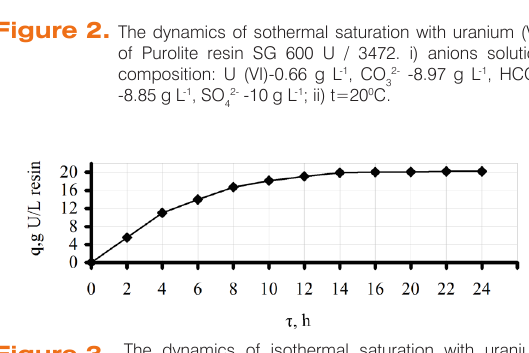
Figure 3. The dynamics of isothermal saturation with uranium (VI) of Purolite resin SG 600 U / 3472. i) anions solution composition: (i) U - 0.66 g L -1 , CO 32- -8.97 g L -1 , HCO 3- -8.85 g L -1 , SO 42- - 23 g L -1 , ii) t=20 0 C.